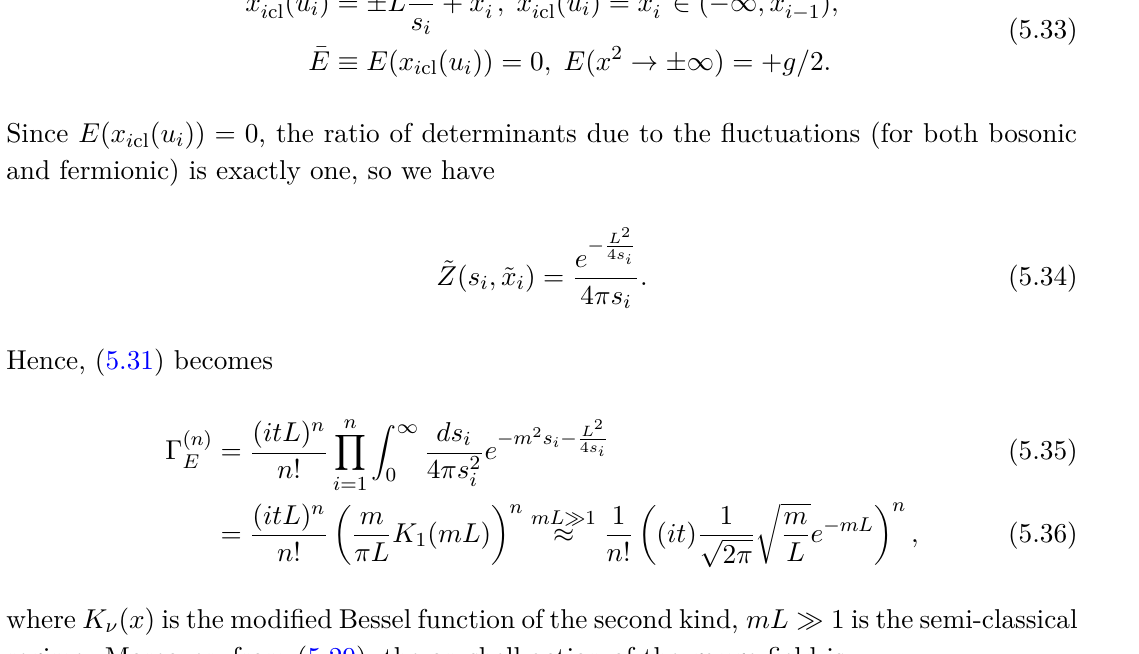
E ( x 2 → ±∞ ) = + g/ 2 , we find that to (5.19) are given